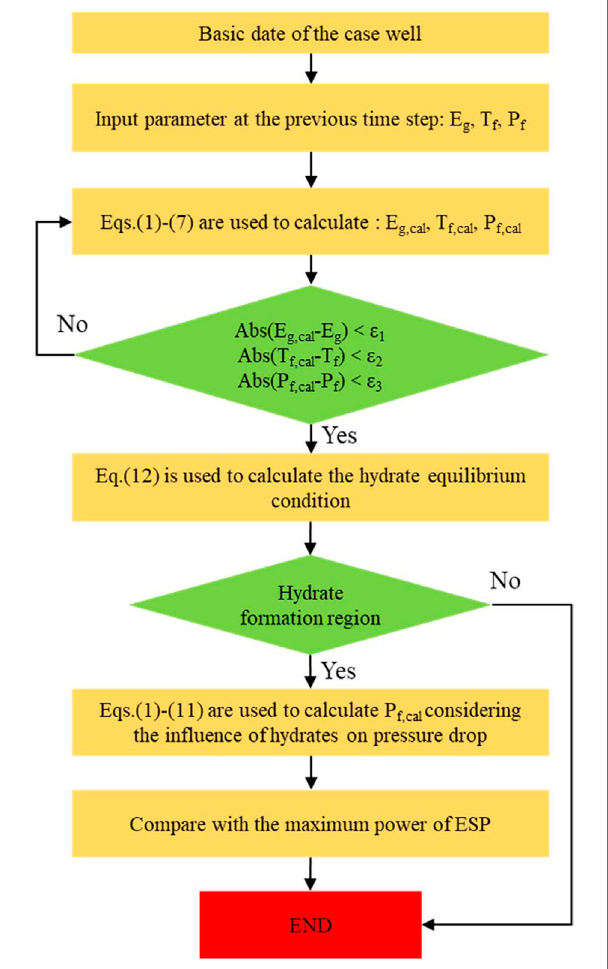
FIGURE 2 | Algorithm for predicting the risk of hydrate in the drainage line during the pilot production of offshore natural gas hydrate.